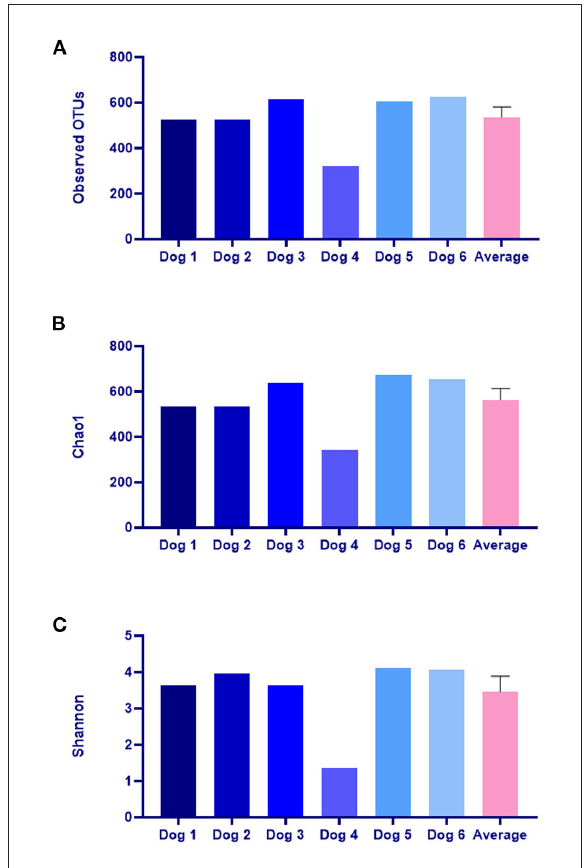
FIGURE9 Analysis of alpha diversity of the skin microbiome including (A) observed OTUs, (B) Chao1, and (C) Shannon. OTUs, Operational Taxonomic Units. The average values are expressed as the mean ± standard